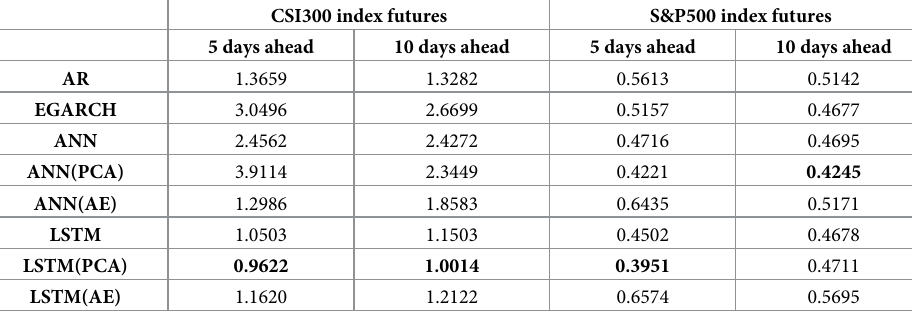
Table 4. Prediction performances in terms of MAE on testing